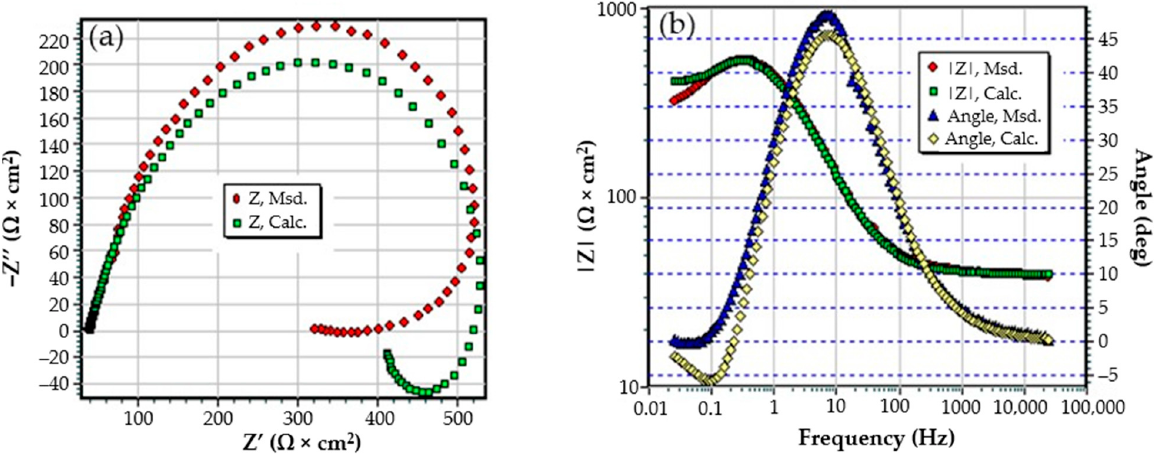
Figure A1. The Nyquist ( a ) and Bode ( b ) diagram for C45 sample after 1 h of immersion in BSW.